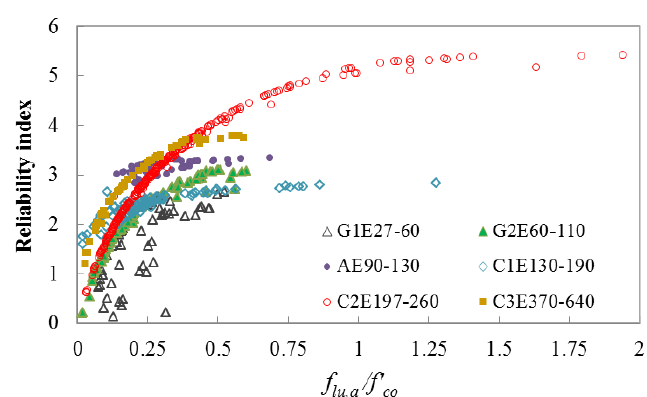
Figure 10. Variation of β with f lu,a / f’ co for different segments of the FRP-confined concrete test database using limit state function of strain capacity.